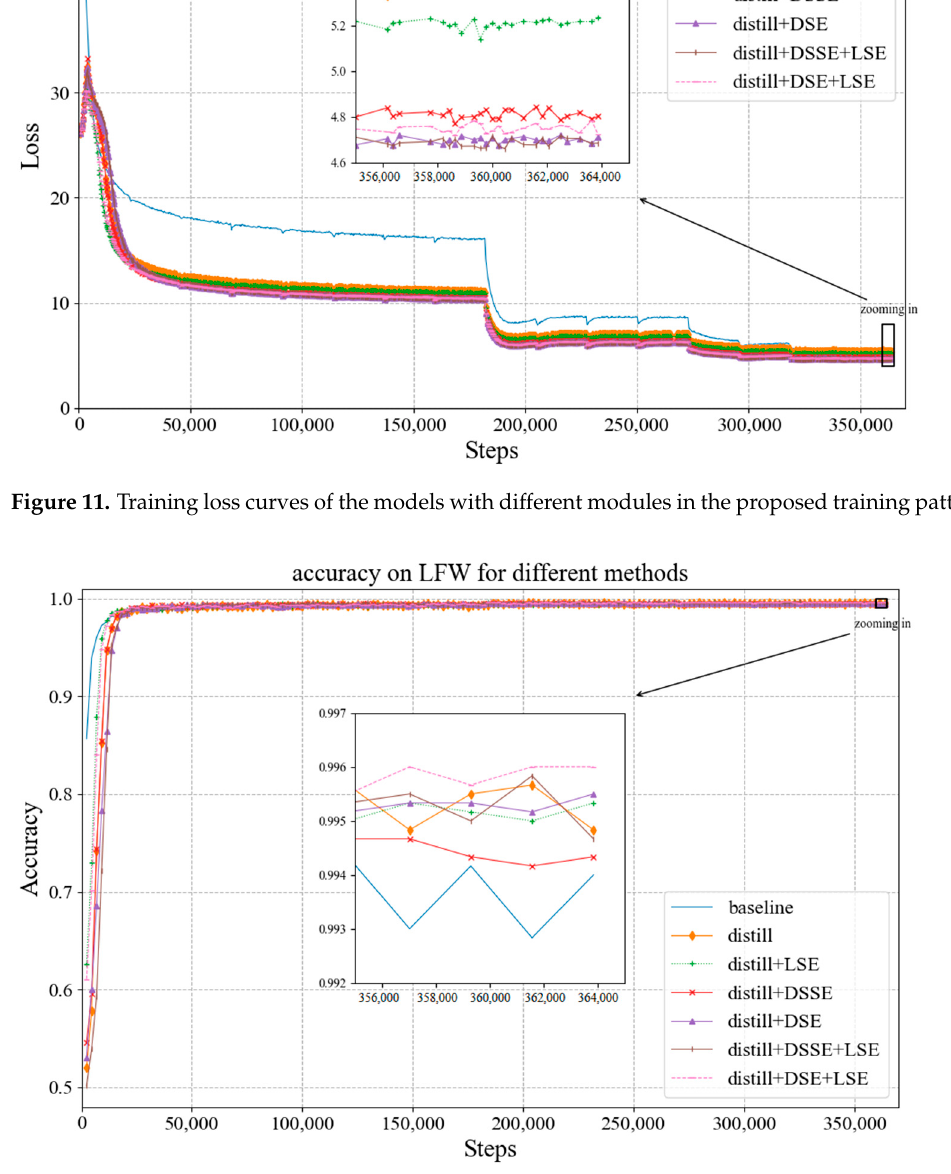
Figure 12. Accuracy curves of the models with different modules in the proposed training pattern.